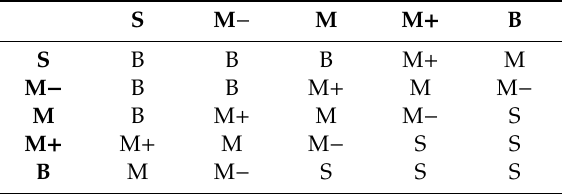
Table 2. Fuzzy control rules.